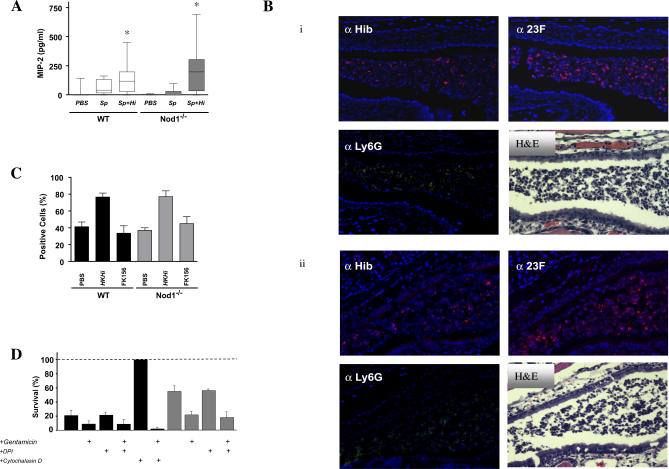
Contribution of Nod1 to Chemokine Production, Neutrophil Recruitment, and Phagocytosis(A) The effect of Nod1 on stimulation of macrophage inhibitory protein (MIP-2) in upper respiratory tract lavage fluid in response to Sp and co-colonization with Hi in Nod1−/− or parental C57Bl/6 mice (WT). Box-and-whiskers plot indicates high and low values, median and interquartile ranges; n ≥ 13 mice from two independent experiments for each co-infected group. *p < 0.02 compared to PBS control.(B) Effect of Nod1 on the neutrophil influx in response to bacteria following co-colonization. Immunofluorescence showing co-localization of Hi and Sp with neutrophils in the murine nasal spaces. Parental (i) or Nod1−/− (ii) mice were co-colonized with Hi636 and Sp1121, and at 24 h post-inoculation, adjacent 5-μm frozen parasagittal tissue sections through the lateral nasal spaces of the same animal were stained with anti-capsular polysaccharide serum specific to type b Hi (αHib), type 23F Sp (α23F), or αLy6.G antibody to mouse neutrophils. Hematoxylin and eosin–stained parasagittal sections (H&E) show the neutrophil influx into the lumen between adjacent nasal turbinates. DAPI nuclear staining (blue). Magnification 200×.(C) FACS analysis of the effect of Nod1 of the influx of activated neutrophils. Administration (i.p.) of casein with 106 heat-inactivated Hi or FK-156 (1.0 μg/animal) was compared to casein alone for the effect on PECs expressing Ly6.G and the activation marker CD11b/CD18. Values represent the percent of total PECs expressing both markers and are means of three independent determinations ± SD.(D) Killing of Sp by neutrophil-enriched PECs at a ratio of one bacterium to 25 effector cells obtained from C57Bl/6 (black bars) or congenic Nod1−/− (grey bars) mice pretreated by i.p. administration of heat-inactivated whole Hi636 (HKHi). Where indicated, activated neutrophils were treated ex vivo with cytochalasin D, an inhibitor of actin polymerization, or DPI, an inhibitor of NADPH oxidase and the oxidative burst. Survival of intracellular Sp was based on bacterial counts following treatment with gentamicin sulfate. Values represent ≥ three independent determinations in duplicate ± SD.